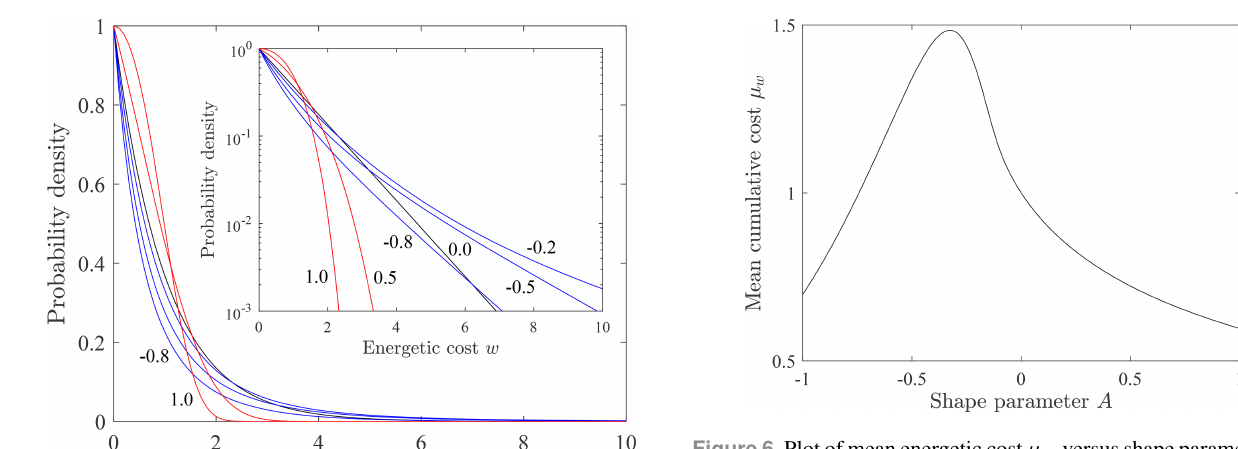
Figure 6. Plot of mean energetic cost µ w versus shape parameter A , showing maximum value at A ≈ − 0 .